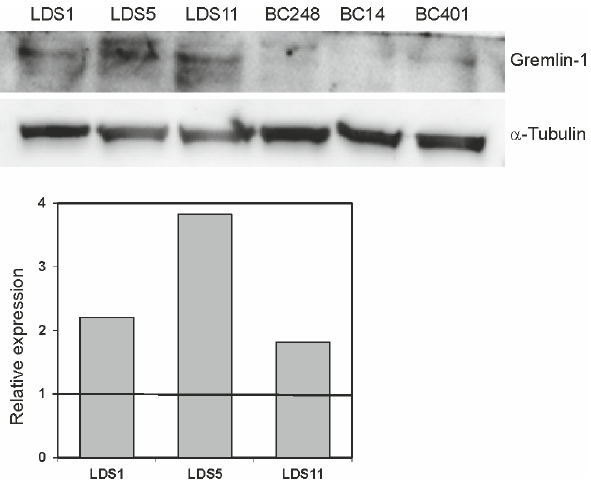
Figure 1. Elevated Gremlin-1 protein expression in LDS-OECs. The Gremlin-1 protein expression in LDS-OECs was compared to OECs isolated from sex- and age-matched healthy donors. Immunoblotting followed by quantification revealed that the Gremlin-1 protein amount was increased in all three LDS-OEC clones compared to their respective control.